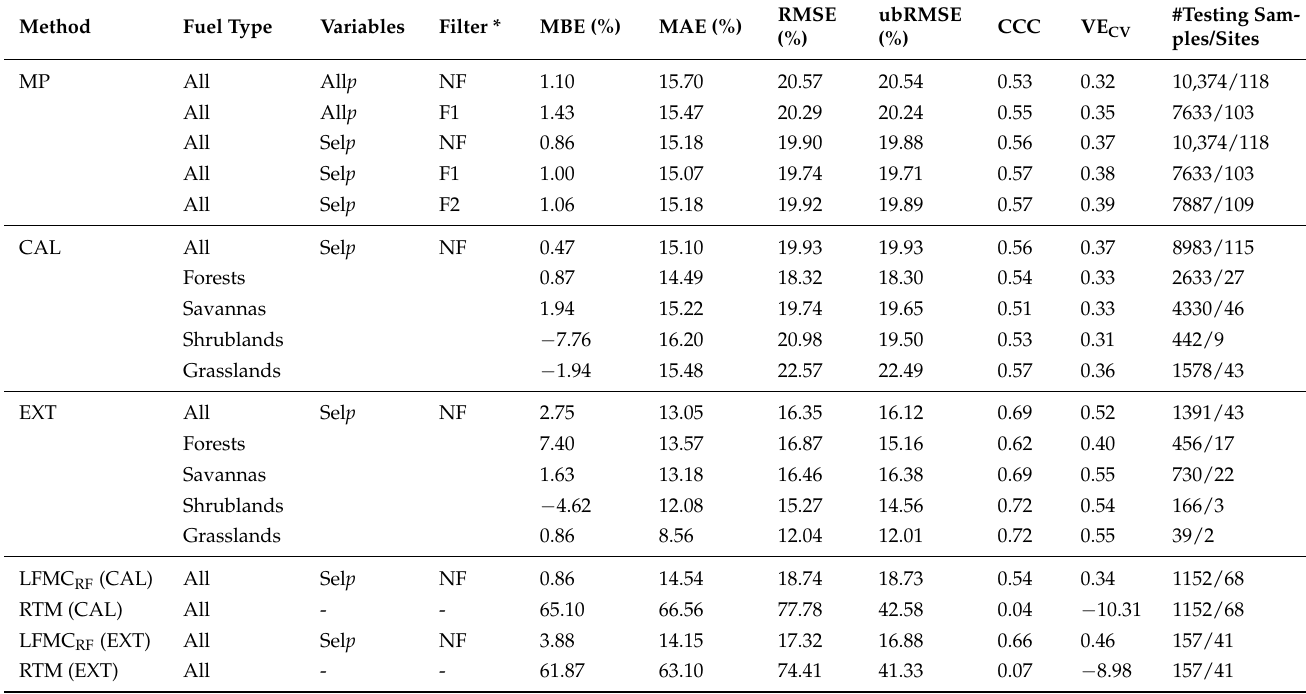
Table 2. Evaluation metrics from predicted and observed values of the model performance (MP), spatial cross-validation (CAL), and the time extrapolation (EXT) assessment. Different methods based on the NDVI CV filter application and the complete (Allp) or selected (Selp) predictive variables. Predictions from CAL and EXT broken down by fuel type. RTM extractions and LFMC RF were validated on the same ground-truth observations separately if they were used in CAL or